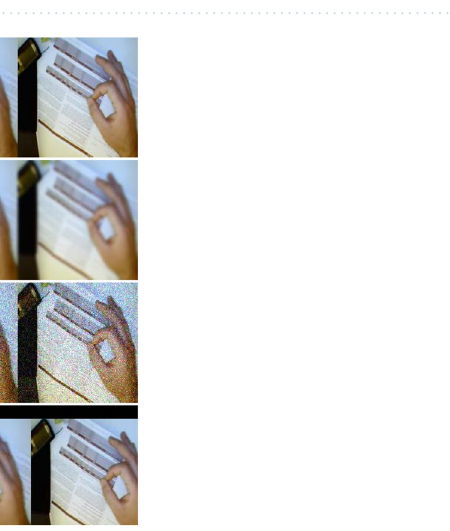
Figure 9. Cross movement trajectory. ( a ) Traditional clustering algorithms, ( b ) proposed clustering algorithm.